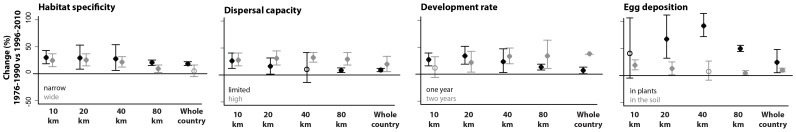
Trends in species richness change (ΔS% +−95% confidence interval) for the non-food trait based subsets of Orthoptera species.Trends at the 10, 20, 40, 80 km grids and whole country. See table S3 of the supporting material for the numbers of grid cells. Filled symbols indicate change of significantly diffrent from zero; open symbols indicate that change was not significantly different from zero. A pair of results is considered not to be significantly different if the error bars do not overlap.